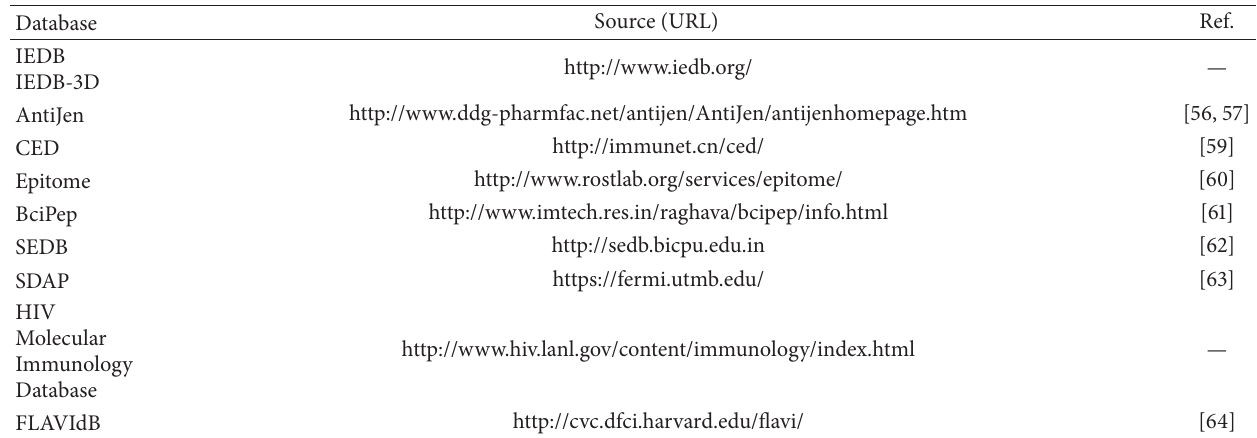
Table 1: List of B-cell epitope